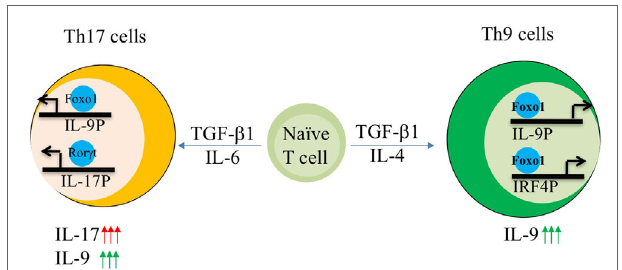
FiGURe 2 | AKT–Foxo1 axis regulates interleukin (IL)-17, IL-9 induction in Th9 and Th17 cells. Fine tuning of Akt–Foxo1 axis determines the production of IL-9 in both Th9 and Th17 cells. Upon phosphoinositide 3-kinase (PI3K)/ Akt inhibition, Foxo1 is induced in Th9 cells, which in turn binds to both IL-9 and IRF-4 promoter thereby contributing to optimal expression of IL-9 in Th9 cells. Unrestrained activity of Akt regulates IL-17 production by Th17 cells. Inhibition of PI3K/Akt axis suppress IL-17 while enhances IL-9 in Th17 cells leading to a switch from high IL-17 producers to high IL-9 producing Th17